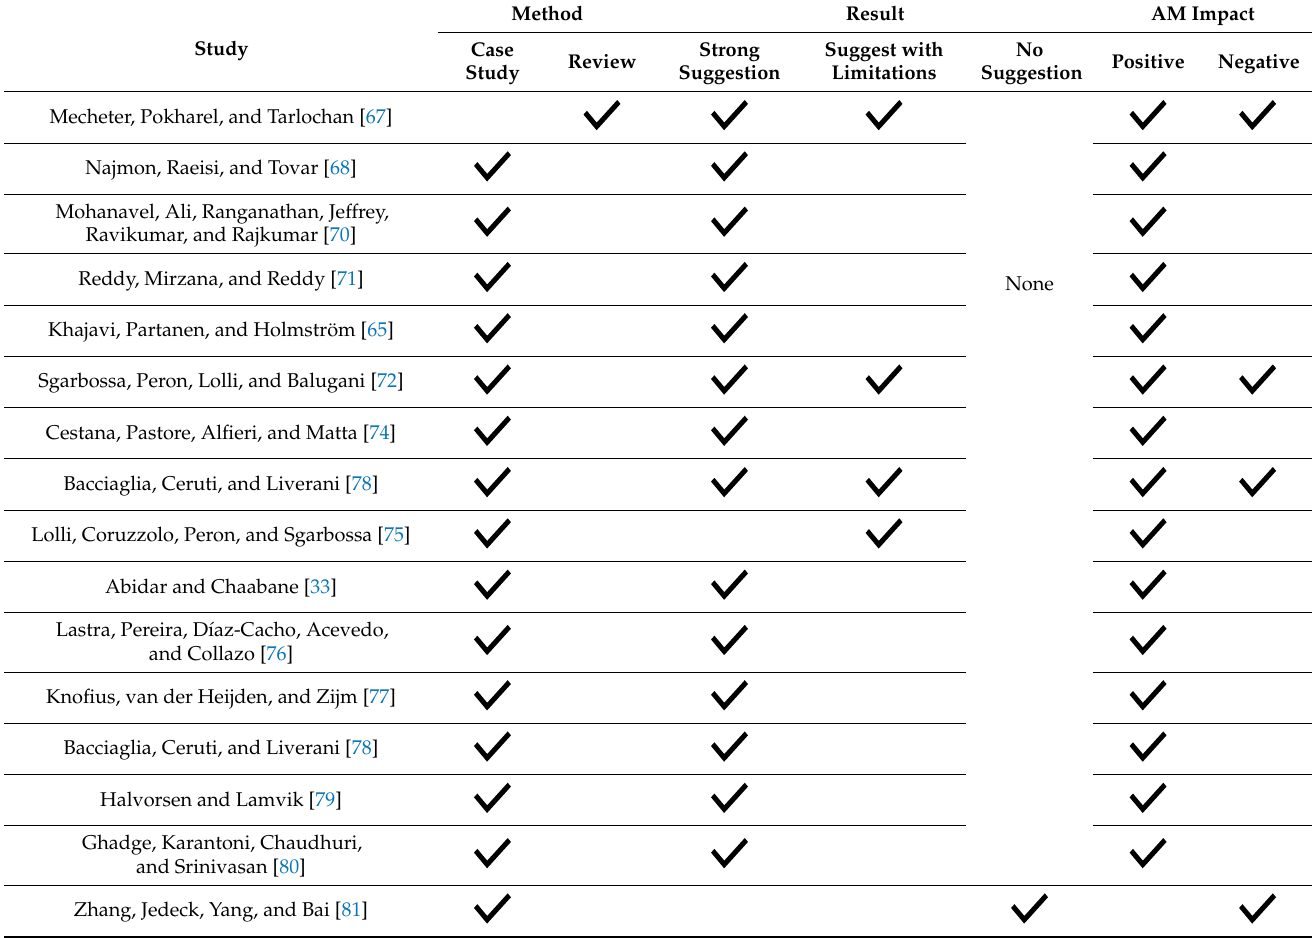
Table 1. List of studies that discussed the impact of AM on spare parts.